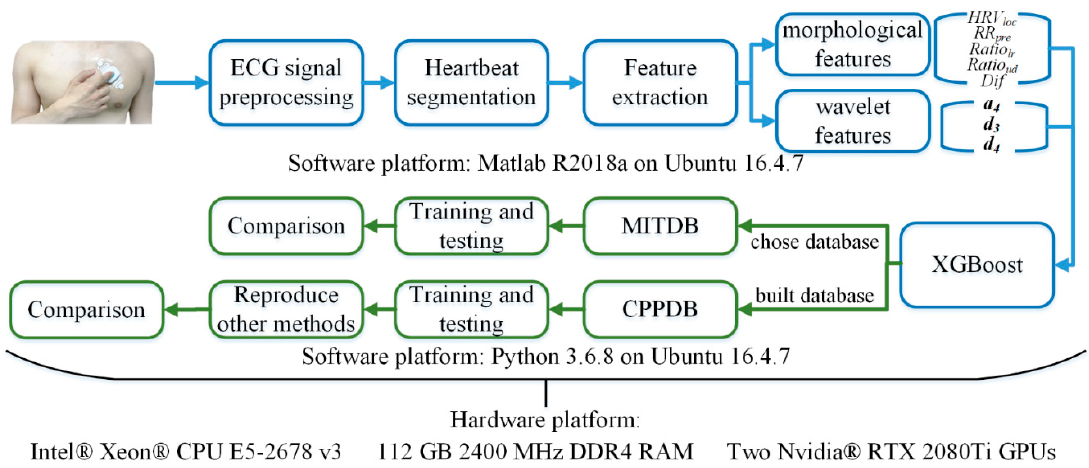
Figure 1. The overview framework of our study, including the framework of the proposed method (blue) and the overview of the conducted experiment (green).